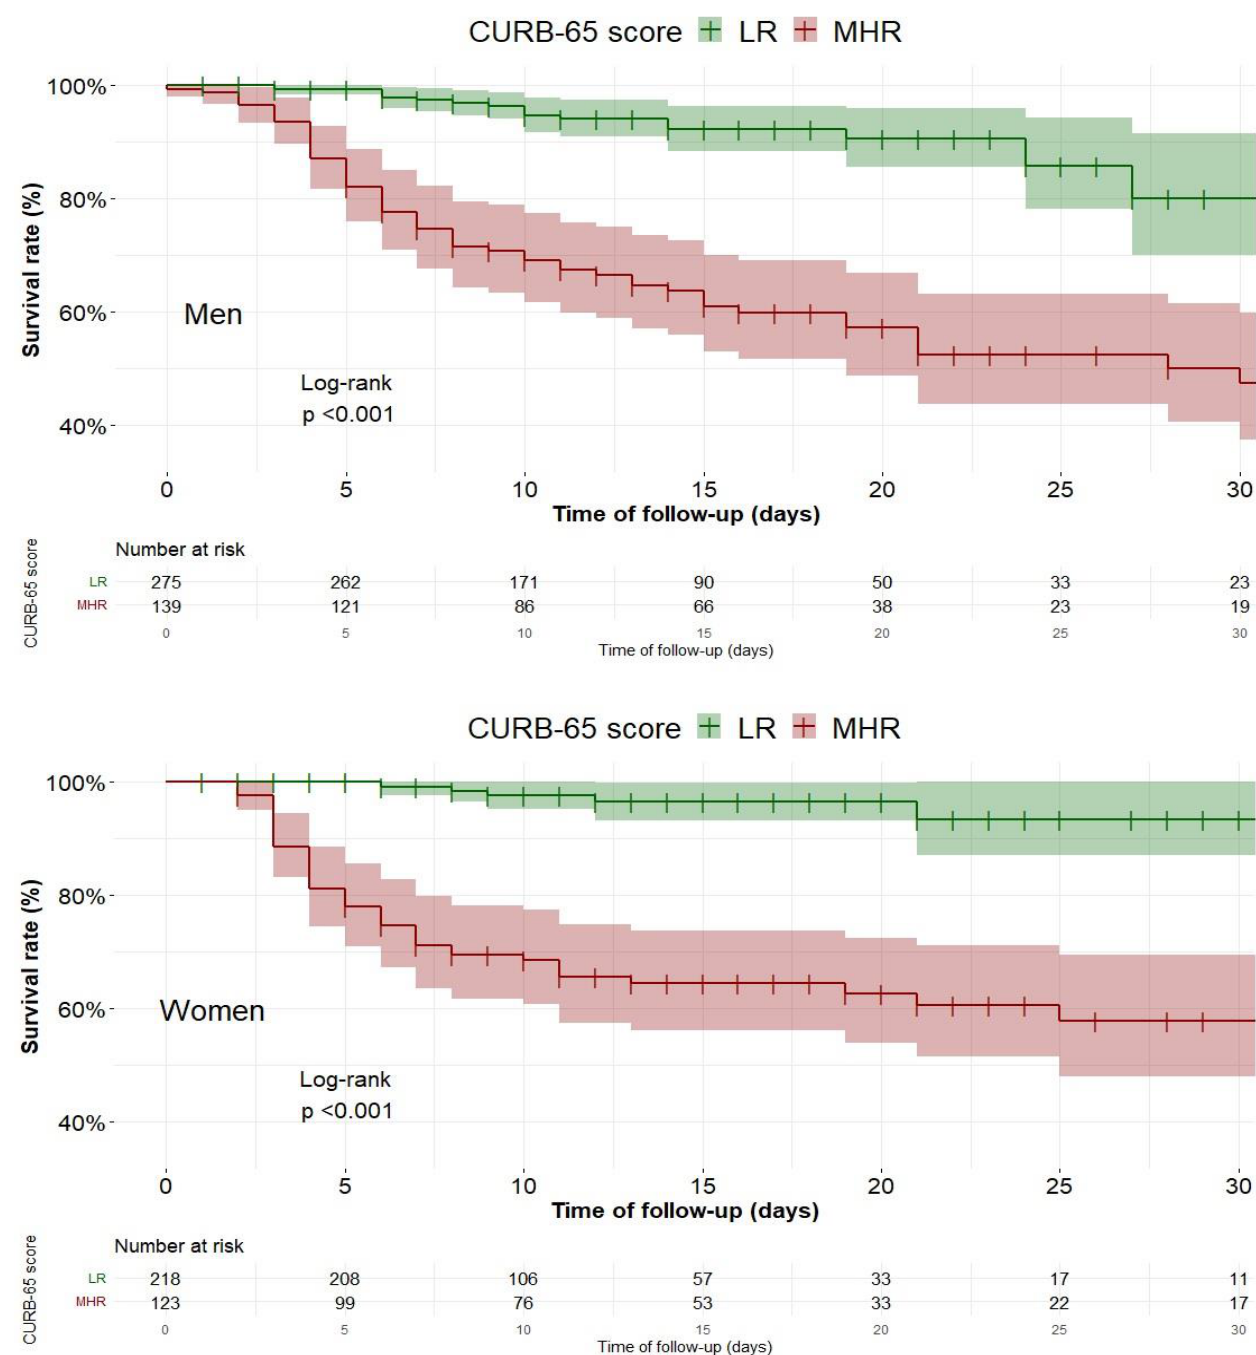
Figure 4. Survival analysis of men ( top ) and women ( bottom ), stratified by low (LR) or medium/high risk (MHR) according to CURB-65 score upon admission, until day 30 of hospitalisation.